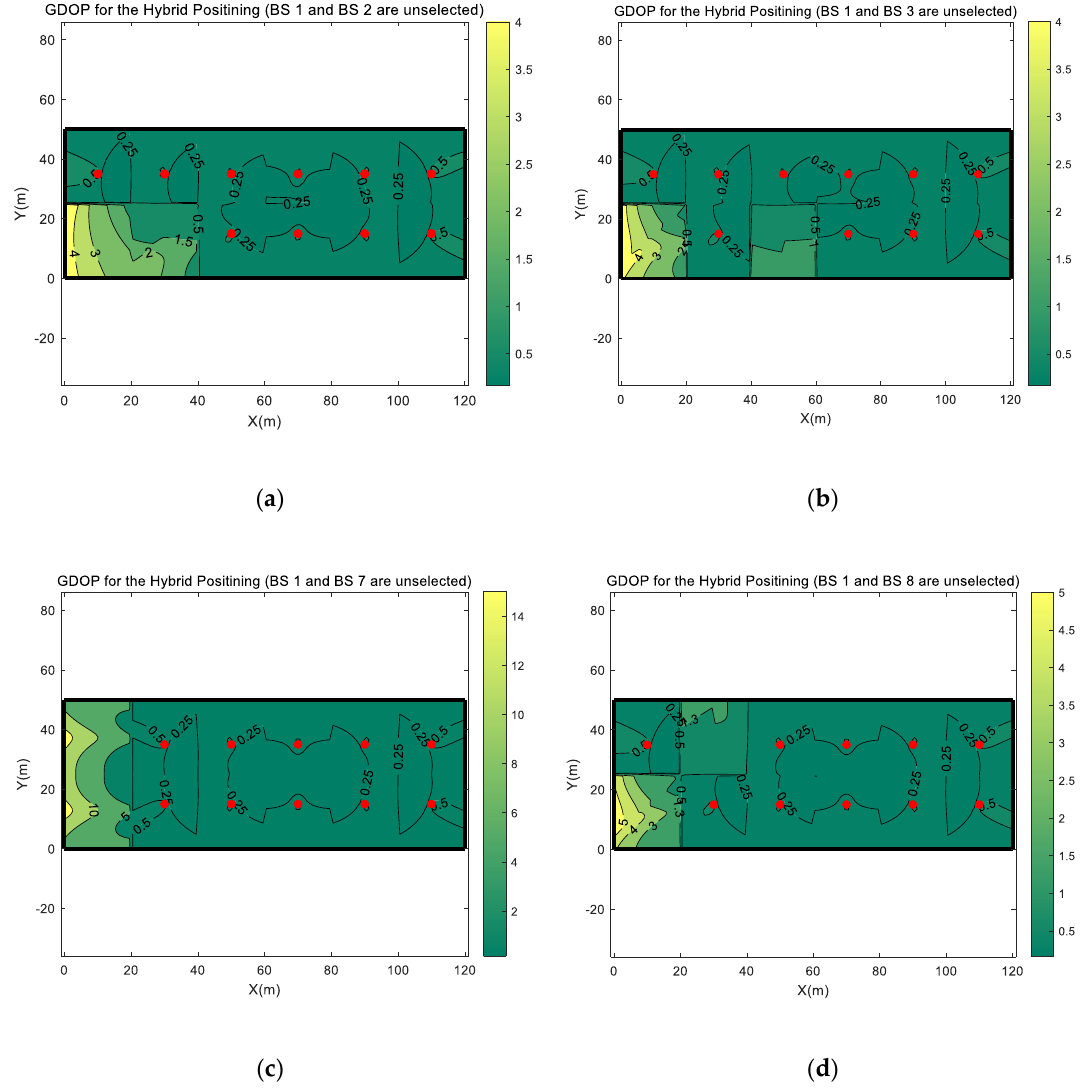
Figure 8. The GDOP distribution of the hybrid positioning when BS 1 and another BS are not selected for positioning. ( a ) the GDOP distribution when BS 1 and BS 2 are not selected; ( b ) the GDOP distribution when BS 1 and BS 3 are not selected; ( c ) the GDOP distribution when BS 1 and BS 7 are not selected; ( d ) the GDOP distribution when BS 1 and BS 8 are not selected.